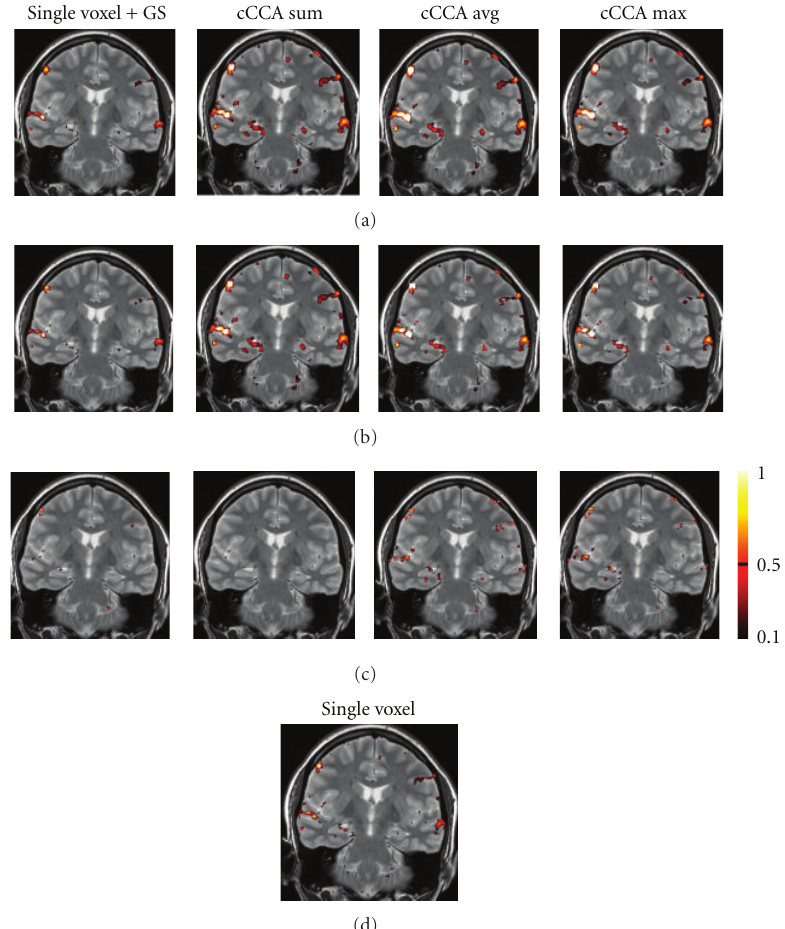
Figure 7: Memory activation maps for contrast “encoding” minus “control” using di ff erent data analysis methods (single voxel with Gaussian smoothing (GS), CCA with the sum constraint (cCCA sum), CCA with the average constraint (cCCA avg), and CCA with the maximum constraint (cCCA max)). In (a), original activations maps are shown at FWE < 0.05. In (b), activation maps corrected for the smoothing artifact are shown. Corrections are done for P > 0 . 5. In (c), voxels a ff ected by the smoothing artifact are shown. The color scale on the right refers to the magnitude of the smoothing artifact in (c). In (d) we show for comparison the activation map for single-voxel analysis without Gaussian